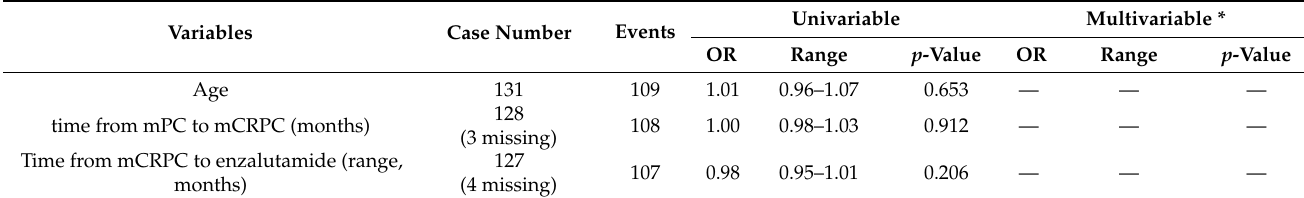
Figure 3. Radiological response in the patients stratified tumor burden. Table 3. Univariable and multivariable analyses of radiological response to enzalutamide in metastatic castration-resistant prostate cancer patient